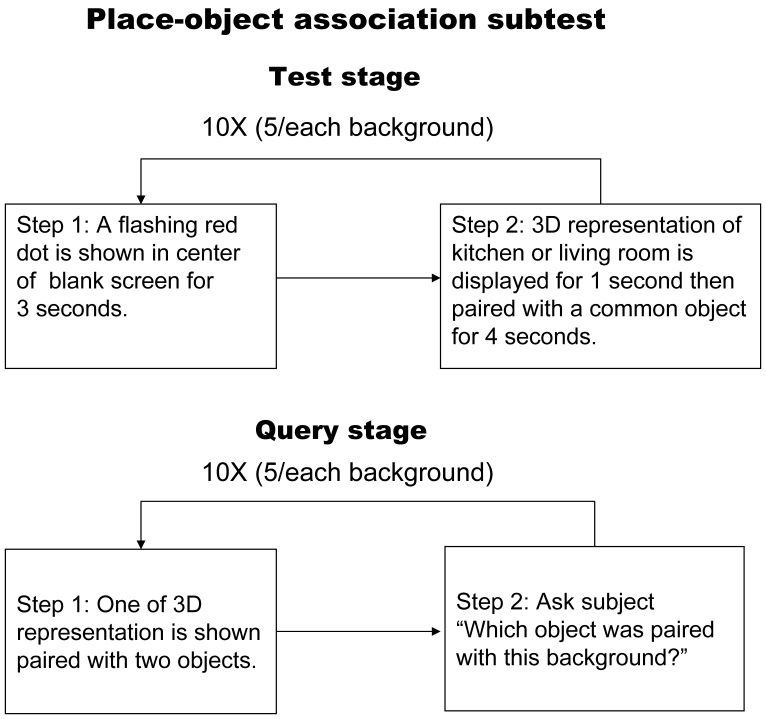
Flow chart illustrating the place-object.